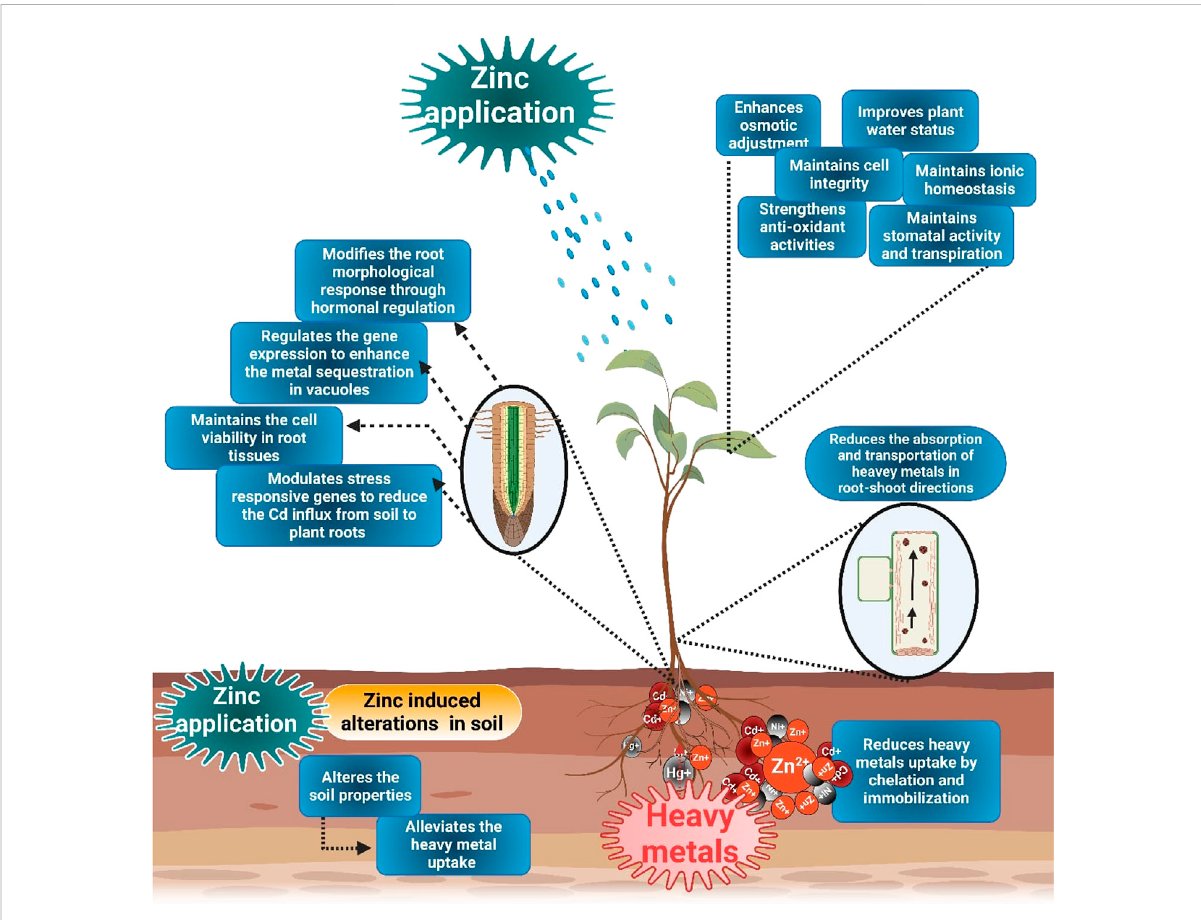
FIGURE 2 Mechanisms ofZn-induced heavymetals toxicityinplants.Theapplication ofZncauseHMschelationandimmobilizationinsoiland,therefore, reduce their uptake. Zn supply also modi fi es root architecture, maintain viability of root cells, and regulate the stress-responsive genes to counter HMs toxicity. Moreover, Zn also maintains membrane stability, improve plant water status, osmolytes accumulation, stomata activities, and ionic homeostasis to counter HMs